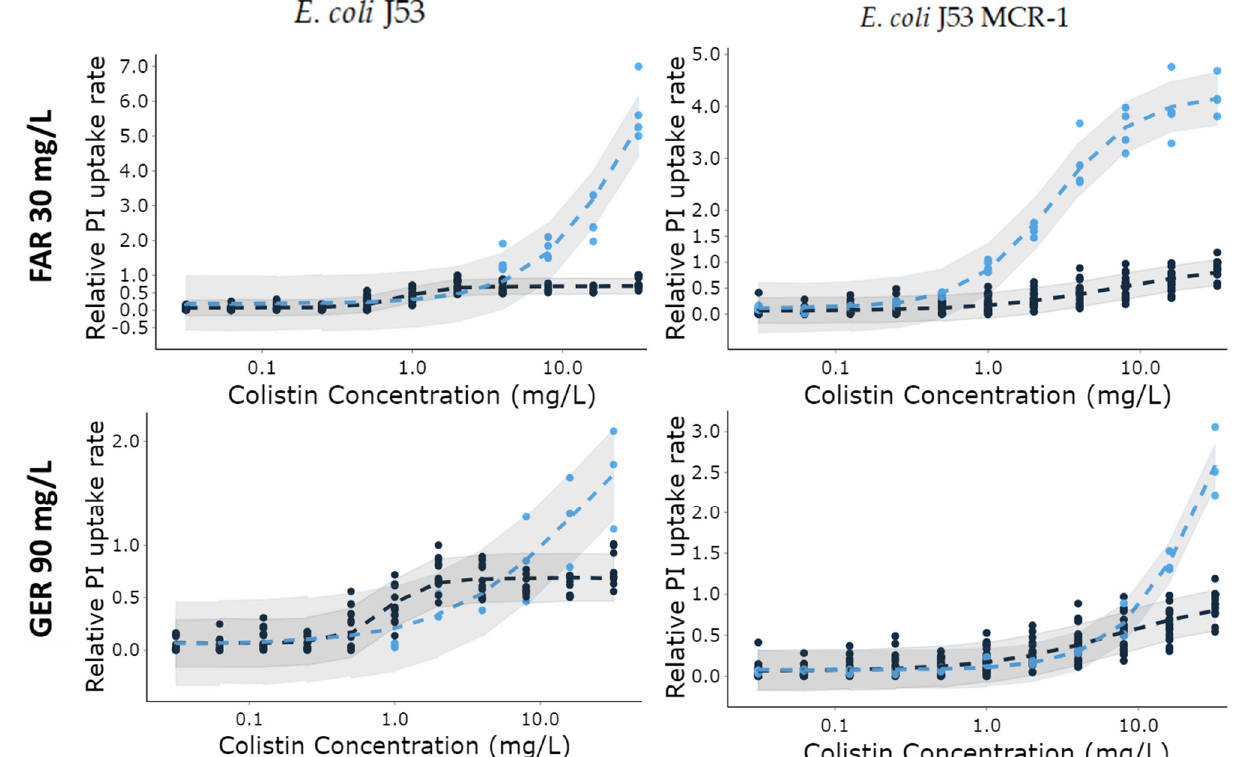
Figure 4. Relative propidium iodate (PI) uptake rate by E. coli J53 (left panels) and E. coli J53 MCR-1 (right panels) measured as a function of colistin concentration alone (black circles) or in the presence of 30 mg/L of farnesol (top-blue circles) or 90 mg/L of geraniol (bottom-blue circles). Uptake rates were normalized against the highest uptake rate measured in the presence of colistin alone at 32 mg/L. When the data described a complete sigmoidal shape, they were analyzed using the E max equation (Equation (2)). The shaded area are the 90% credible intervals around the mean values (lines). (4 ≤ n ≤ 20).